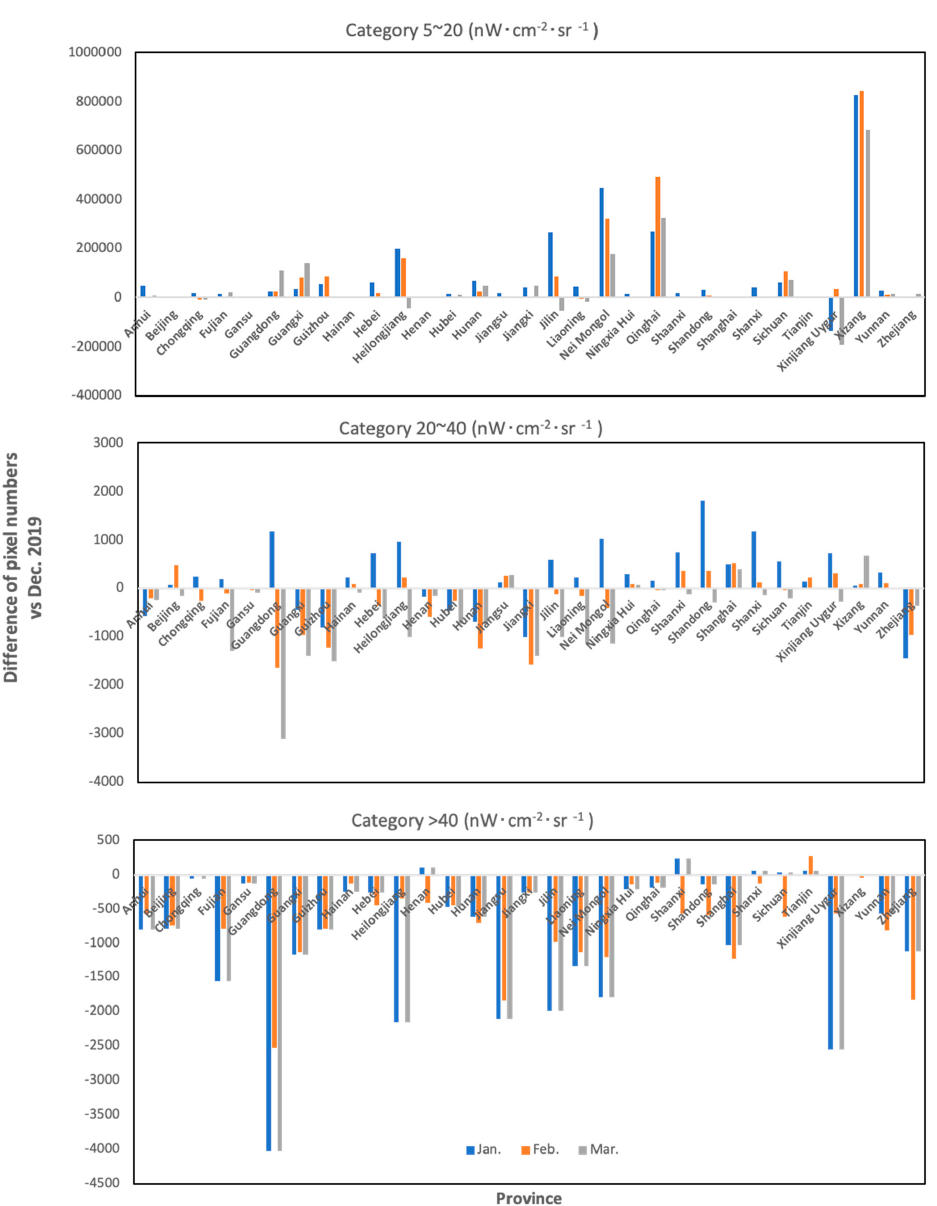
Figure 4. Differences of NOP in the three NTL categories between the first three months of 2020 and December 2019, in each province of China. The residential area NTL is increasing during the pandemic (top), the transportation and public facility NTL has a drop trend in most provinces (middle), while the commercial center NTL has a sharp drop in almost every province.